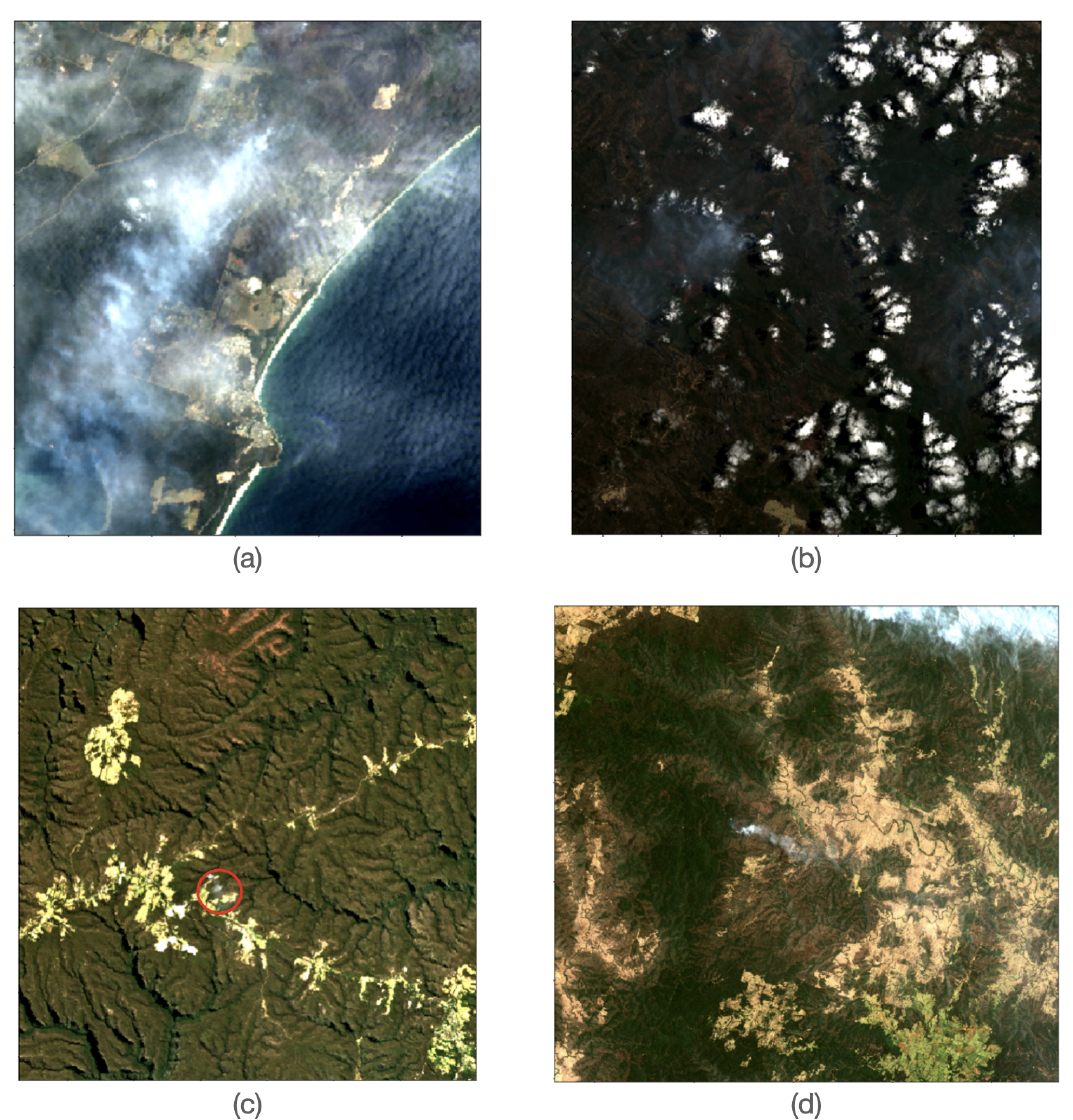
Figure 9. Fire smoke scenes. ( a ) Fire smoke mixed with thin clouds above the seaside. ( b ) Diffused fire smoke at multiple sites under altocumulus clouds. ( c ) Cloud-free fire smoke (in the red circle) over a very small geographic extent. ( d ) Cloud-free fire smoke plumes in different scales at two different